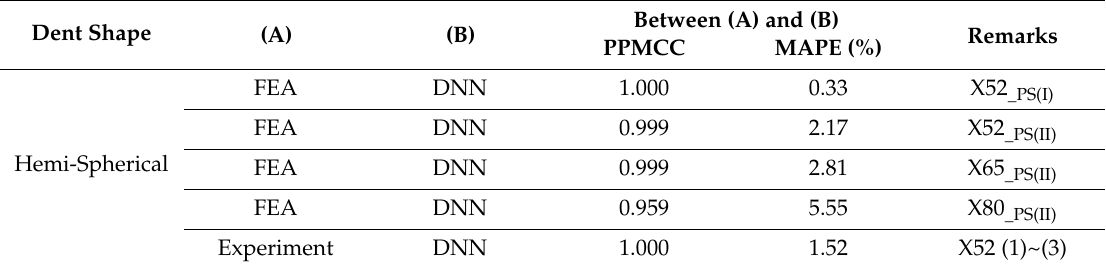
Table 8. Summary of PPMCCs and MAPEs based on the burst pressure predicted by FEA and DNN. Dent Shape (A) (B)